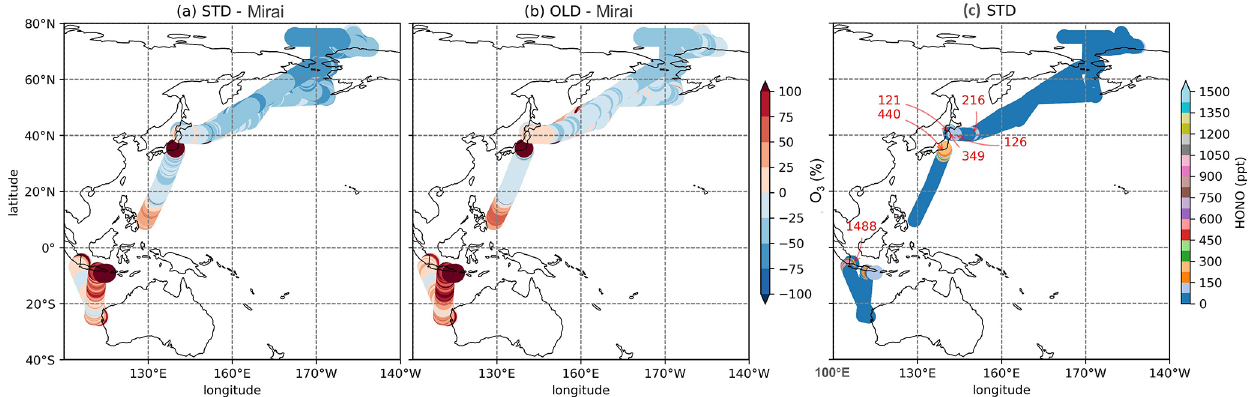
Figure 6. Percentage discrepancies of STD (a) and OLD (b) simulations from Mirai for O 3 and HONO concentration in STD (c) . The red numbers in panel (c) indicate maximum HONO concentrations for each cruise.